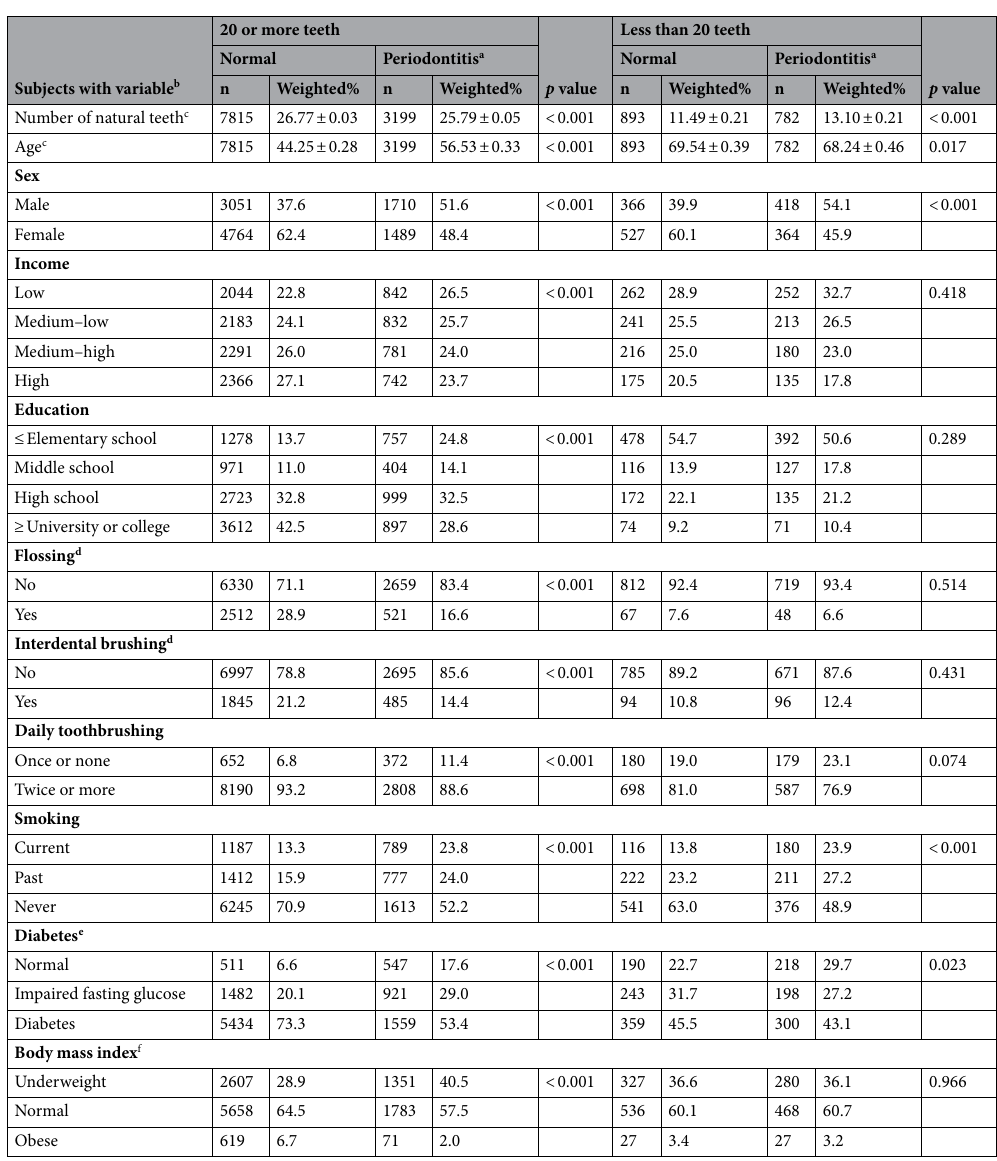
Table 1. Characteristics of the study population stratified by periodontitis. a Periodontitis was defined as community periodontal index codes 3 and 4. b All variables have a number of different missing values, so the total number by each variable is different. c Continuous variables are denoted by the mean ± standard error. d Daily use of interdental brush and dental floss. e Impaired fasting glucose was defined as 100 mg/dL ≤ fasting blood glucose < 126 mg/dL, and diabetes was defined as fasting blood glucose ≥ 126 mg/dL or current use of antidiabetic drugs or insulin. f Obesity status was defined as underweight (< 18.5 kg/m 2 ), normal (18.5–24.9 kg/ m 2 ), and obese (≥ 25.0 kg/m 2